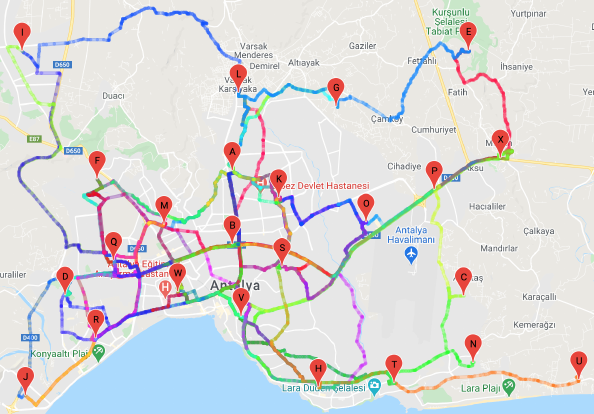
Figure 1: Nodes with All Selected Routes Routes are drawn in different colors in order to distinguish them from each other. The colors of the routes using common roads are mixed due to the existence of many routes, the routes cannot